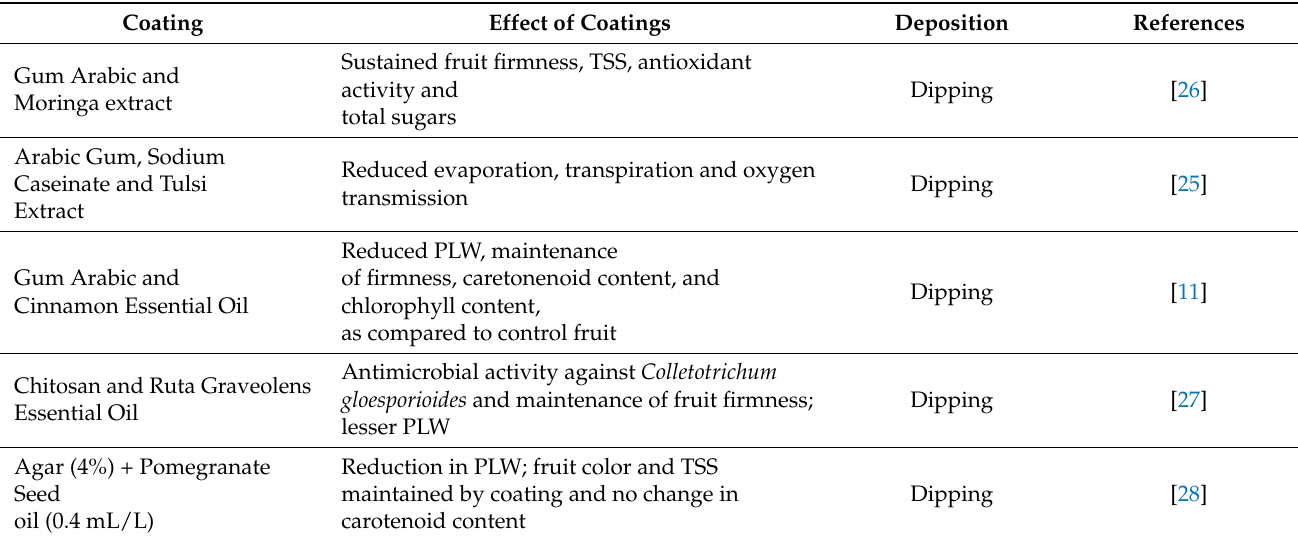
Table 3. Effect on edible coatings on shelf life of